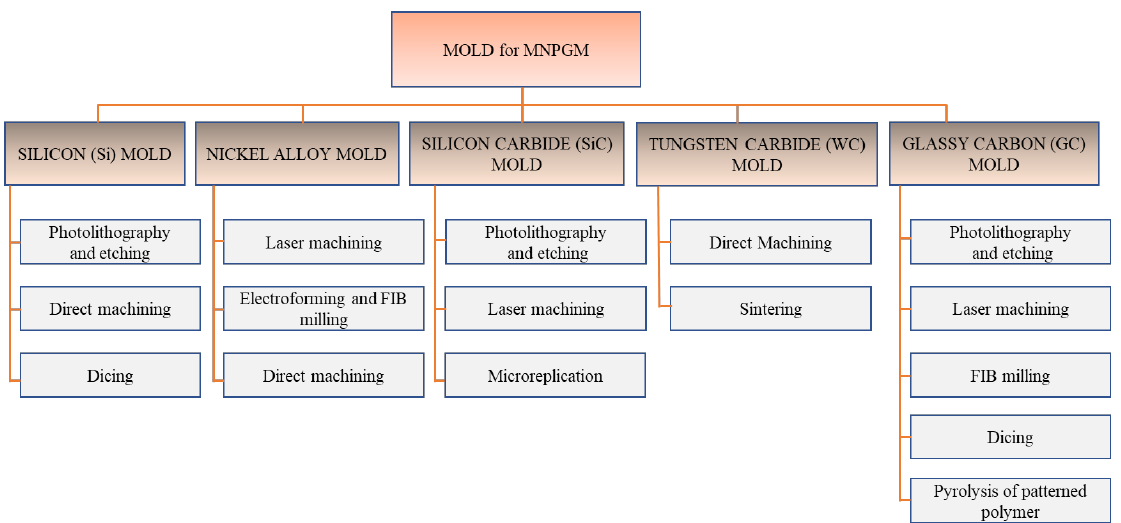
Figure 8. Schematic representation of the various mold fabrication techniques available for precision glass molding. In direct machining, 3D microstructures with ultra-low surface roughness (e.g., 2